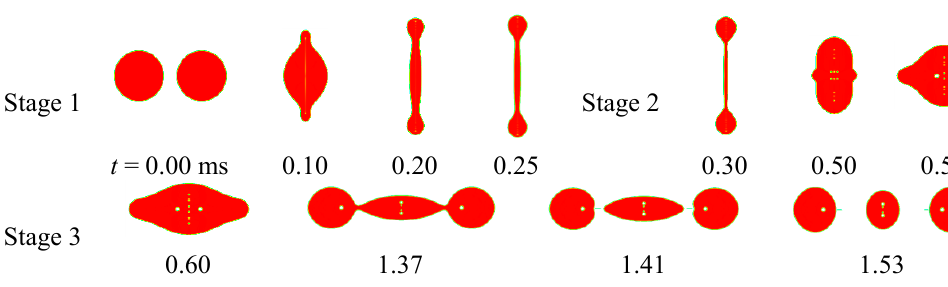
Figure 10. Time evolution for reflexive separation collision.